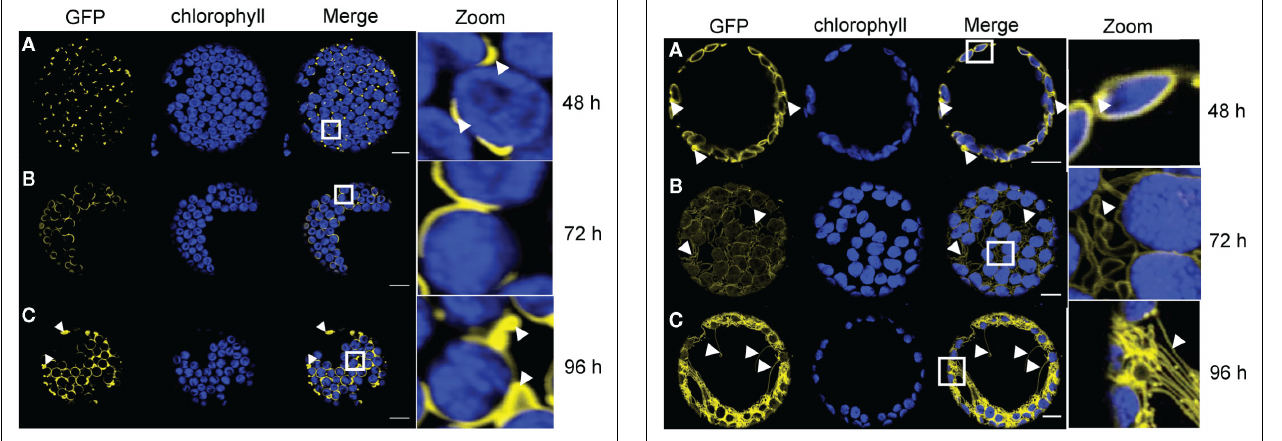
FIGURE 2 |Time course analysis of expression patterns for AtTIC40–GFP in N. benthamiana protoplasts. Time based confocal microscopic analysis on isolated protoplasts of N. benthamiana leaves after 35S-promoter driven in planta expression of AtTIC40–GFP. GFP fluorescence (GFP) in yellow, chlorophyll autofluorescence (chlorophyll) in blue, an overlay (merge) and a magnification (zoom) of representative protoplasts are shown.The white box indicates the merged region magnified under zoom. (A) Expression pattern 2days (48h) after Agrobacterium infiltration shows short crescent moon-like structures (arrowheads) and dots associated with the chloroplasts. GFP signal slightly departs from chlorophyll autofluorescence. (B) Expression pattern 3days (72h) after Agrobacterium infiltration displays half circles around the chloroplasts. (C) Expression pattern 4days (96h) after Agrobacterium infiltration shows partially full circles surrounding the chloroplasts, interrupted circles, and scattered extensions (arrowheads). Size bars: 10 μ m.